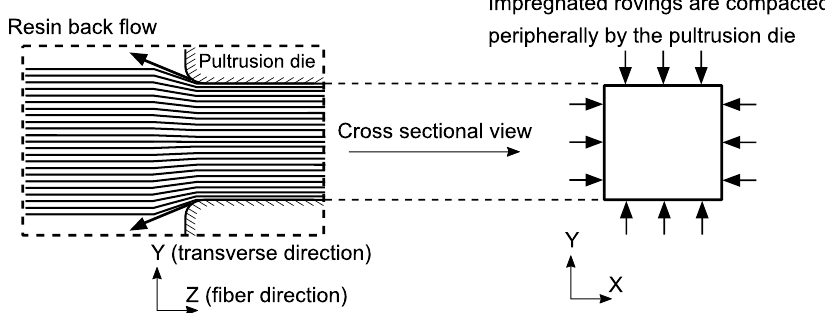
Figure 1. Schematic representation of the peripheral